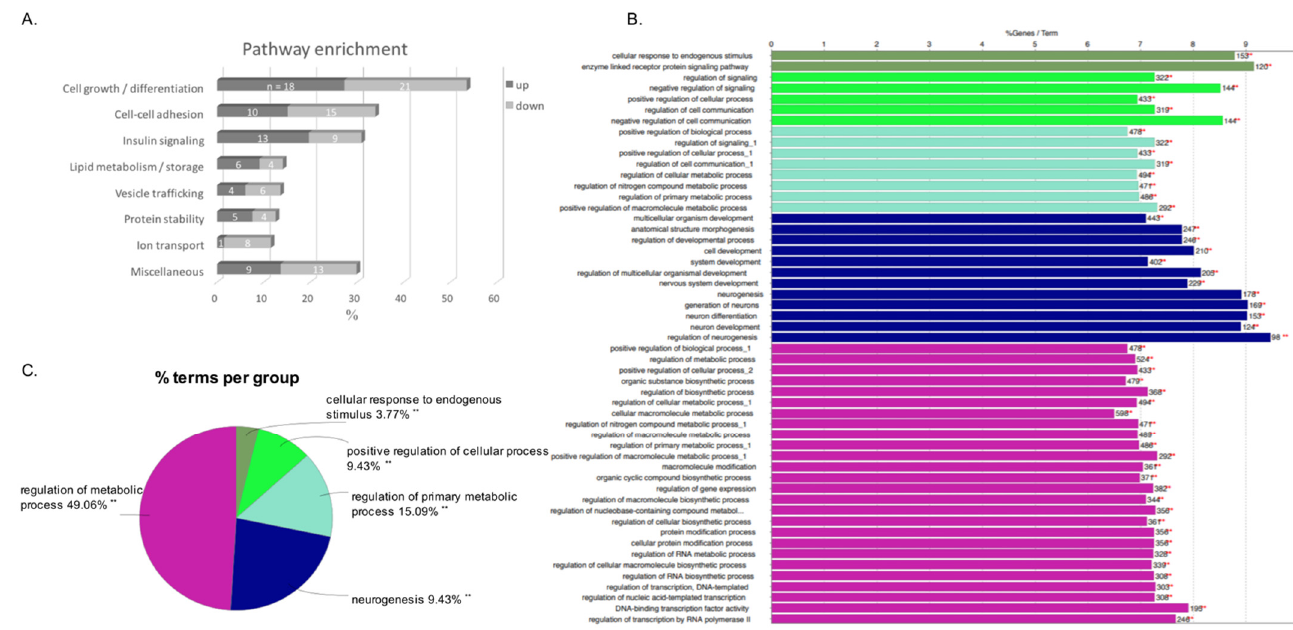
Figure 3. ( A ) Top 40 biological processes and pathways associated with up- and downregulated miRNAs in MUO individuals. ( B ) Upregulated GO/pathway terms specific for target genes. Bars represent the number of genes associated with the terms. The percentage of genes per term is labelled in the bar. ( C ) Overview chart with the enriched functional groups including specific terms for target genes.